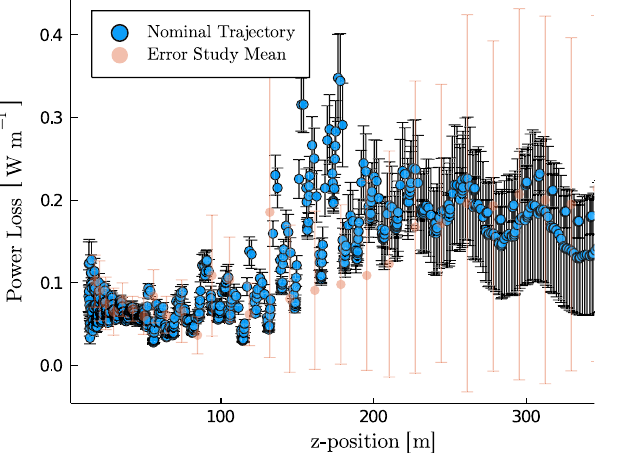
FIG. 7. Traversal of H 0 particles from the point of IBST to collision with the nearest machine-element wall or aperture (for the same beam and machine parameters used in Fig. 6). Inset shows the depositions occurring within 2 m of